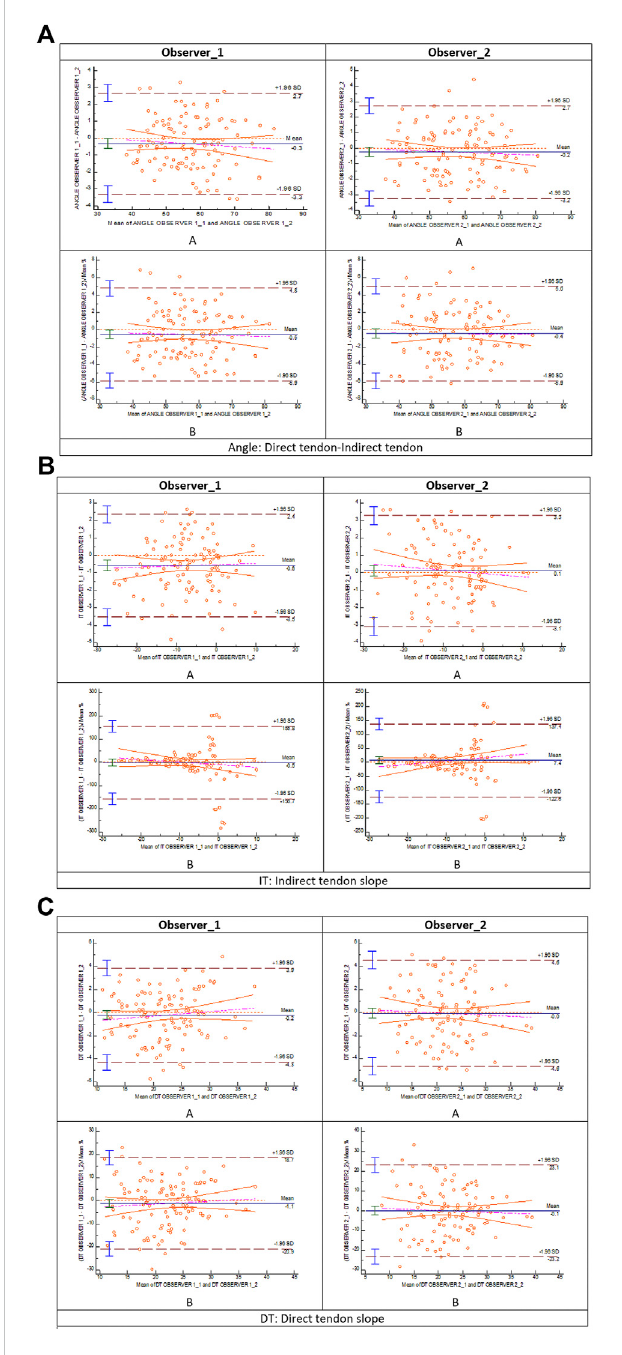
FIGURE 7 Bland and Altman: intra-observer analysis (A: Bland – Altman plot; (B) plot of differences between measure 1 and measure 2 for observer 1 and observer 2 as percentages of the values on the axis vs . the mean of the two measurements) for (A) direct tendon – indirect tendon angle, (B) indirect tendon slope, and (C) direct tendon slope.